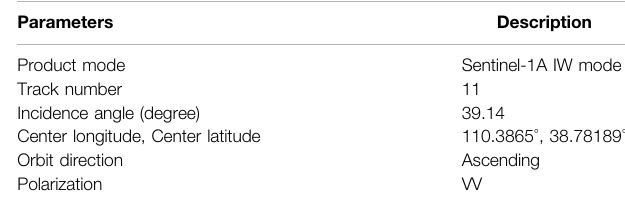
TABLE 1 | Speci fi c parameters of the used Sentinel-1A